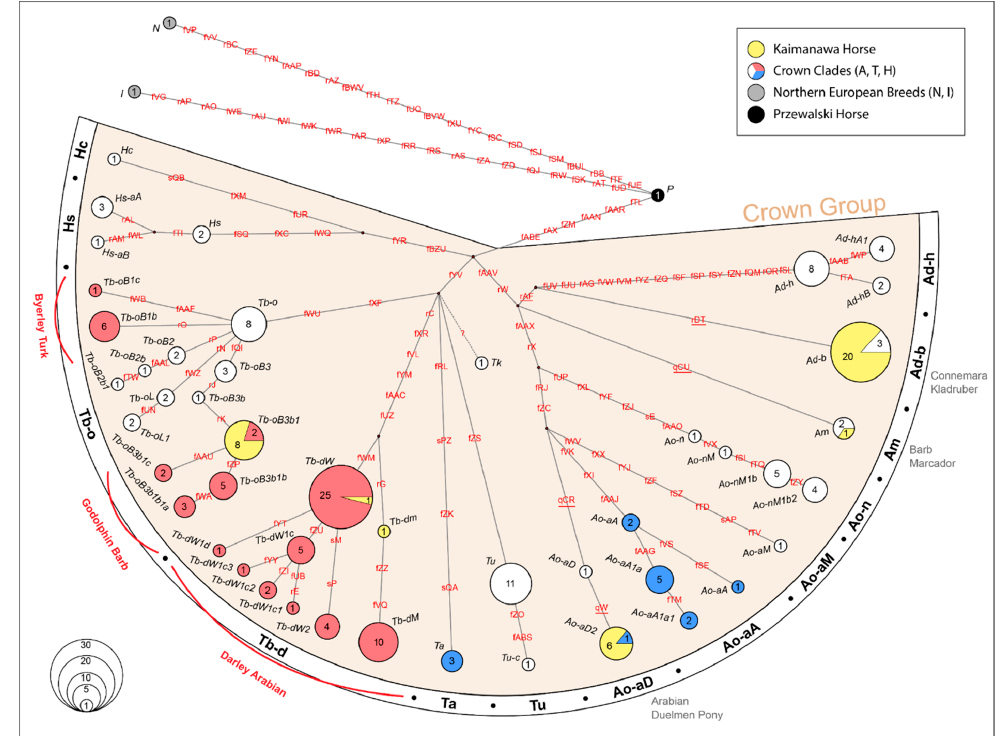
Figure 3. Median Joining network depicting Y-chromosome (Y-chr) haplogroup distribution in KHs in relation to the global modern horse breeds [34] based on 157 Y-chr SNPs. Haplotypes are indicated as circles and the numbers inside represent the number of individuals. The name of the variants observed in each haplotype are shown in red. The variants genotyped using KASP are distinguished by underline. The MJ network [28] was constructed using NETWORK v10.2.0.0 software (https://www.fluxus-engineering.com, accessed on 6 October 2022), by applying uniform substitution weights and without activating the external rooting